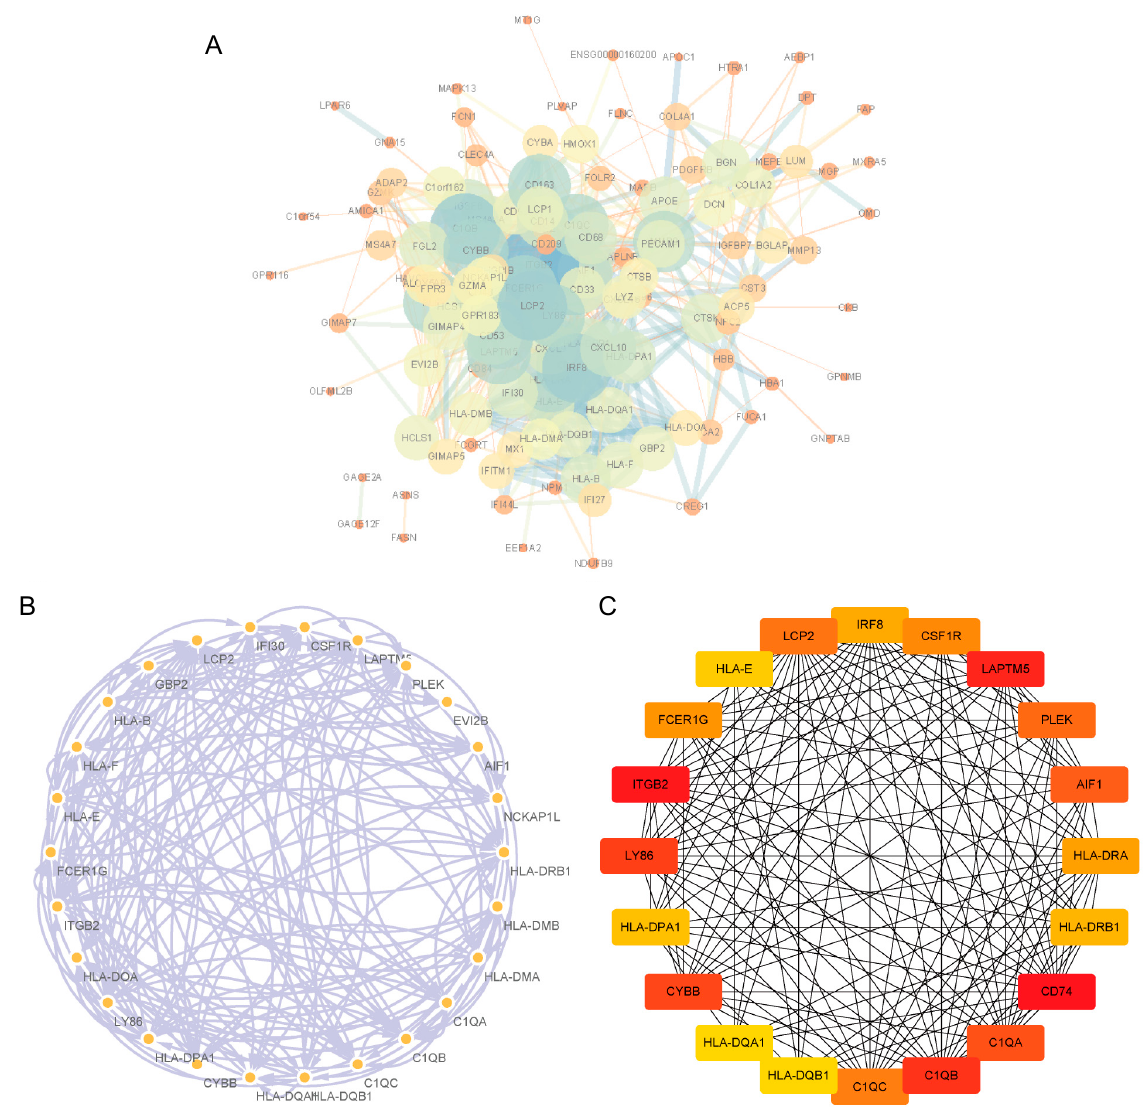
Figure 3. PPI network: ( A ) A PPI interaction network was constructed by using the molecular interaction list obtained from STRING database. ( B ) Hub gene sets obtained using MCODE of Cytoscape. ( C ) The top 20 hub genes obtained using cytoHubba of Cytoscape.